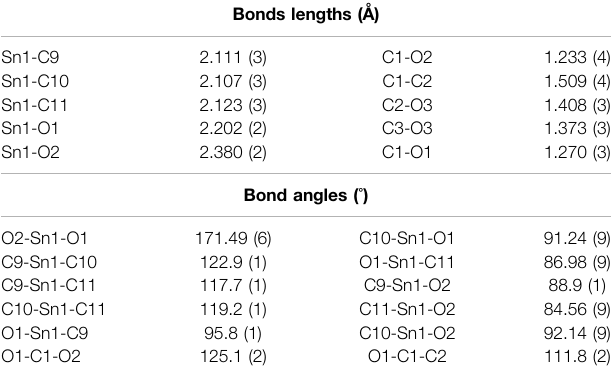
TABLE 2 | Selected bonds lengths (Å) and bonds angles ( ° ) of complex 4